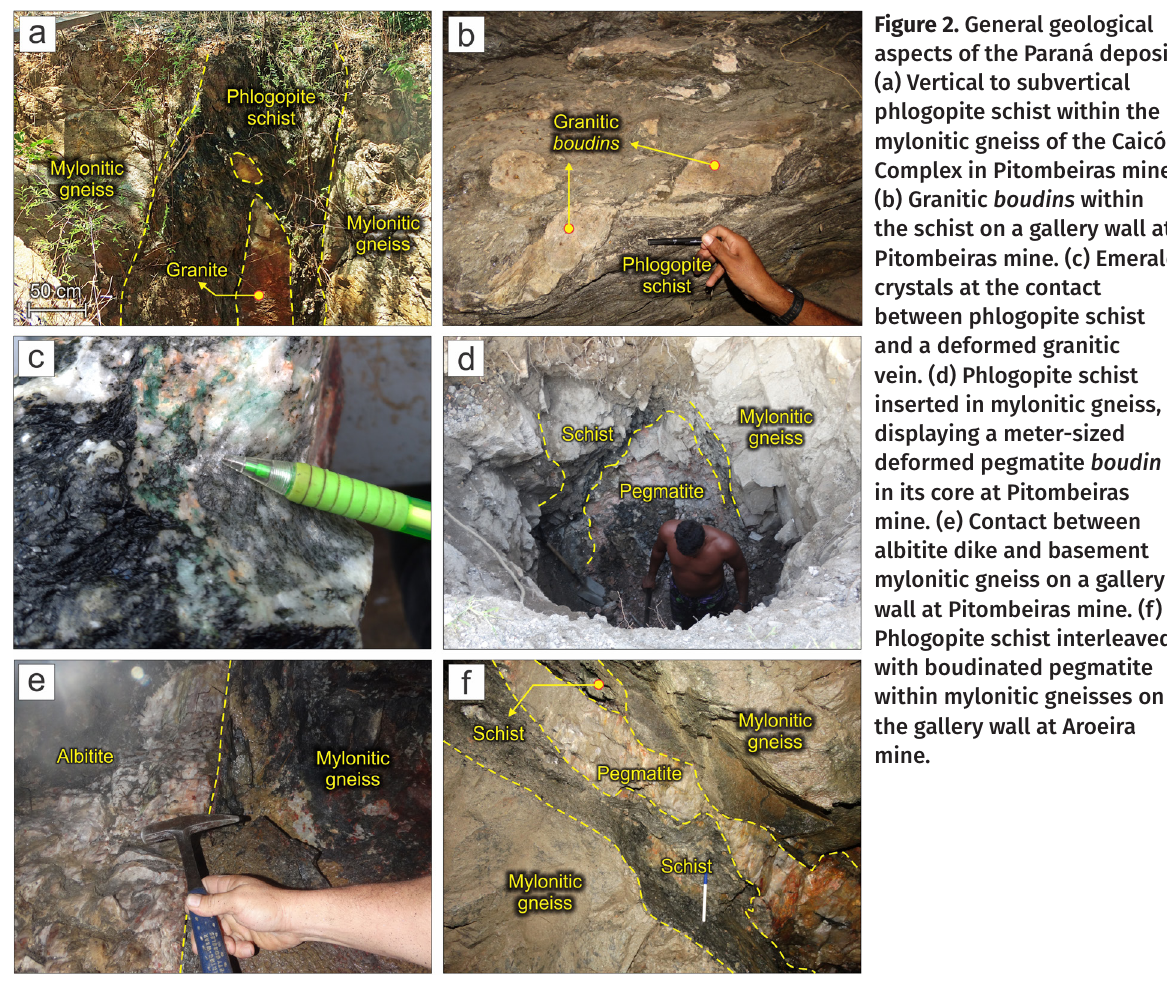
Figure 2. General geological aspects of the Paraná deposit. (a) Vertical to subvertical phlogopite schist within the mylonitic gneiss of the Caicó Complex in Pitombeiras mine. (b) Granitic boudins within the schist on a gallery wall at Pitombeiras mine. (c) Emerald crystals at the contact between phlogopite schist and a deformed granitic vein. (d) Phlogopite schist inserted in mylonitic gneiss, displaying a meter-sized deformed pegmatite boudin in its core at Pitombeiras mine. (e) Contact between albitite dike and basement mylonitic gneiss on a gallery wall at Pitombeiras mine. (f) Phlogopite schist interleaved with boudinated pegmatite within mylonitic gneisses on the gallery wall at Aroeira